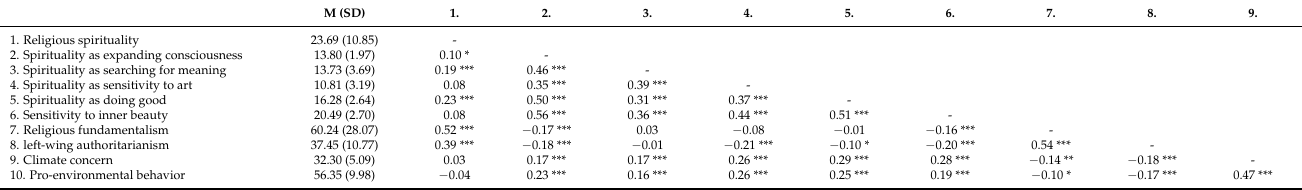
Table 1. Means and correlations (N =